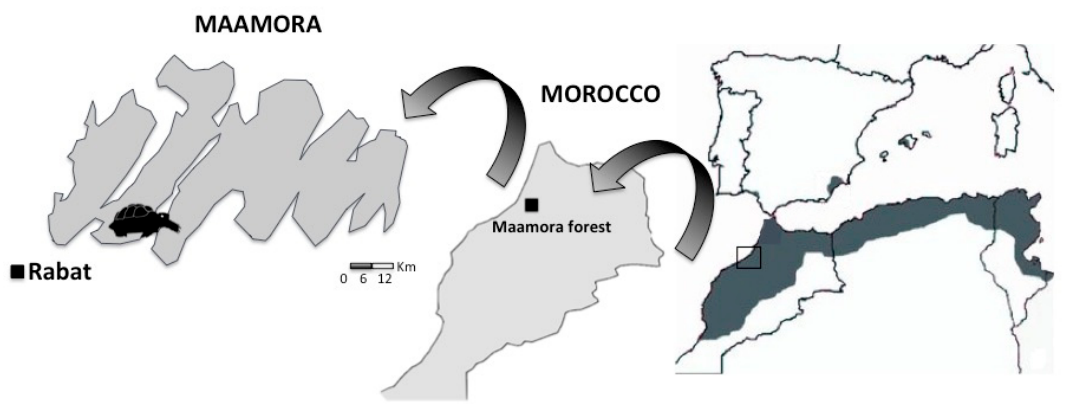
Figure 1. The location of the study area (represented by the tortoise) in Maamora forest, northwestern Morocco, close to Rabat city. The distribution range of Testudo graeca according to Giménez et al. [32] is also shown (dark gray).